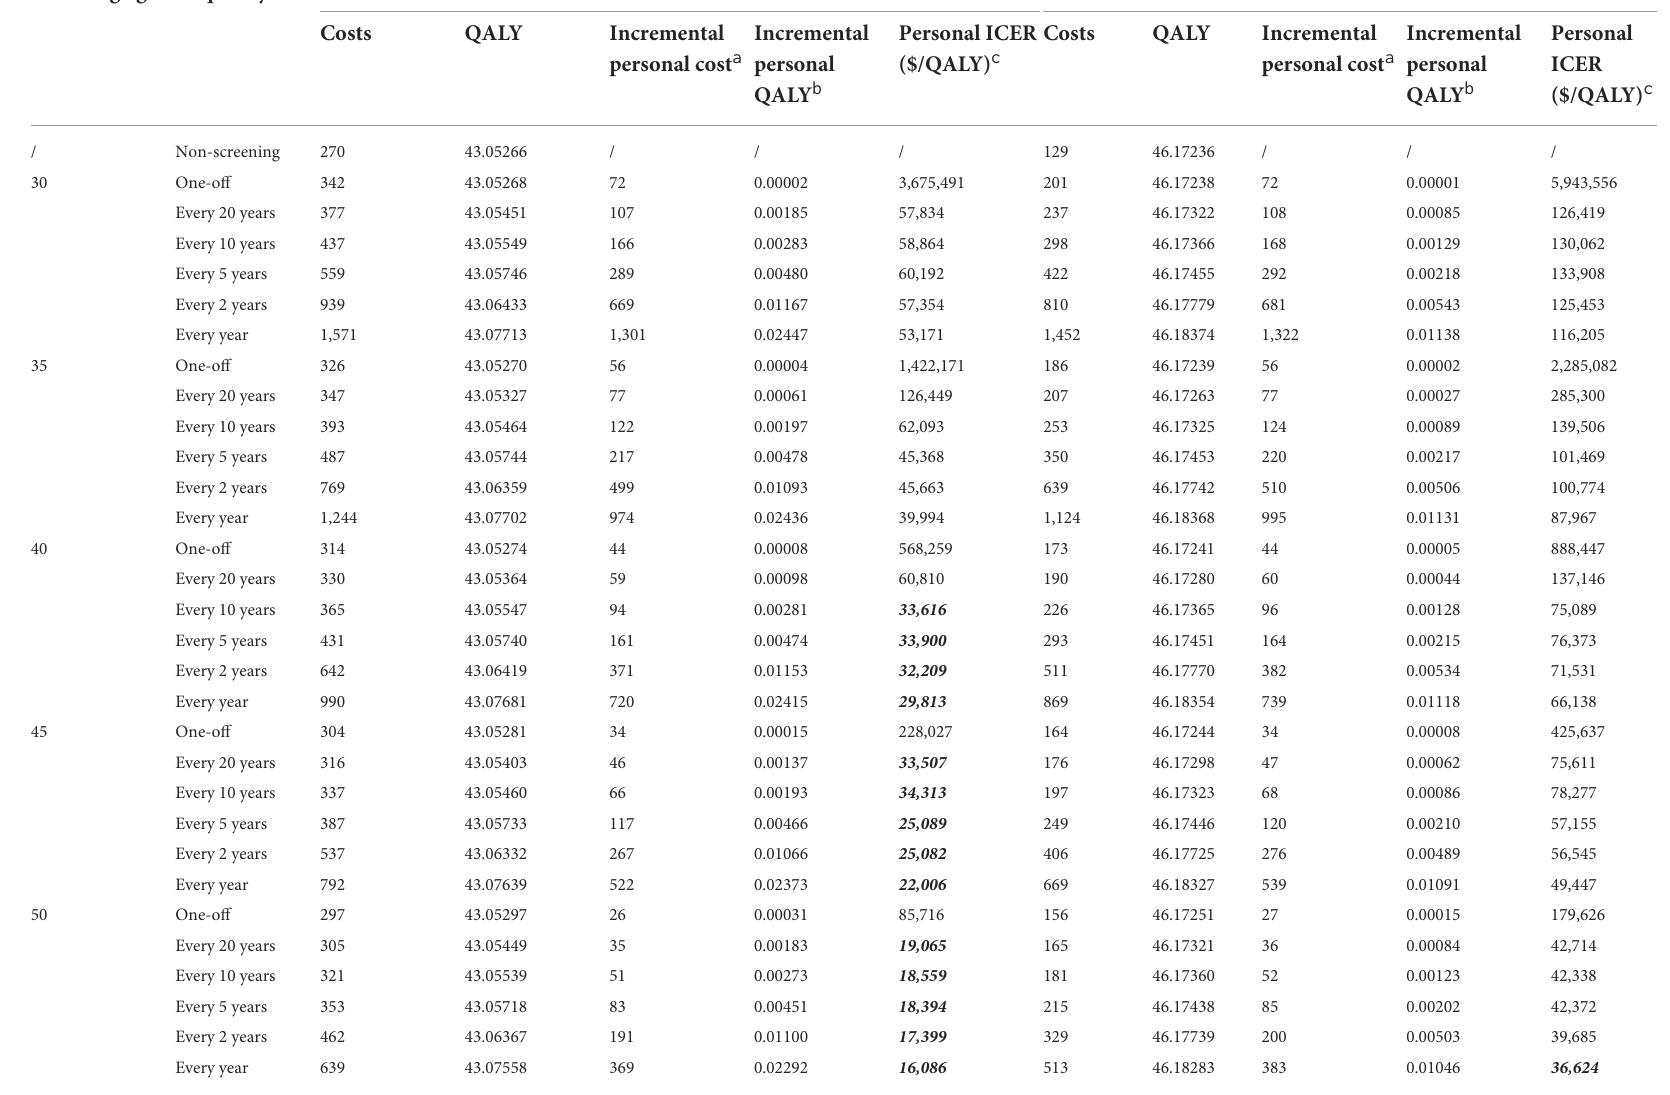
TABLE 2 Cost-effectiveness analysis